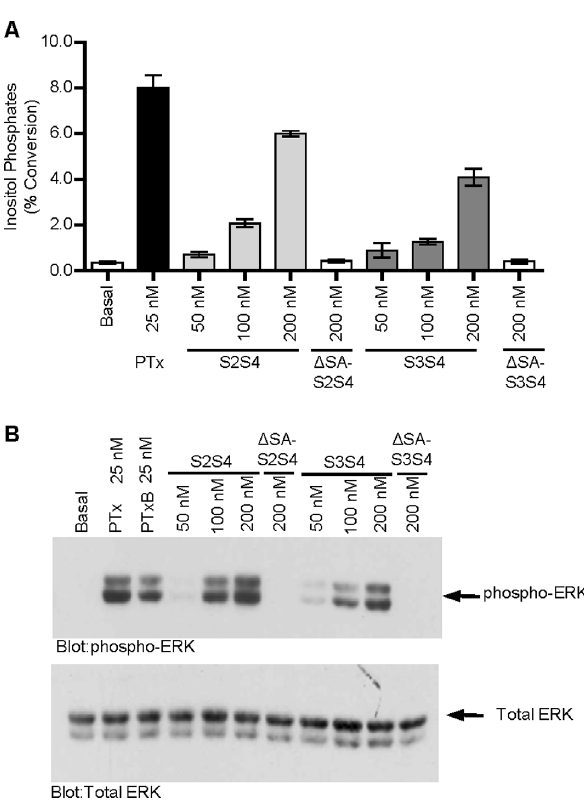
Figure 8. Recombinant S2S4 and S3S4 PTx Dimers are Robust Activators of Signal Transduction in Jurkat cells. Recombinant S2S4 and S3S4 PTx dimers were purified from E. coli and tested for their abilities to activate PLC and the MAP kinase ERK. S2S4 and S3S4 dimers containing mutations in the conserved carbohydrate binding domain ( D SA-S2S4 and D SA-S3S4) were also similarly tested. A. Wild type Jurkat cells were stimulated with the indicated concentrations of dimers and PLC activity was measured using the inositol phosphate accumulation assay. B. Wildtype Jurkat cells were stimulated with the indicated concentrations of dimers and ERK activity was measured by western blot using phospho-specific ERK antibodies.